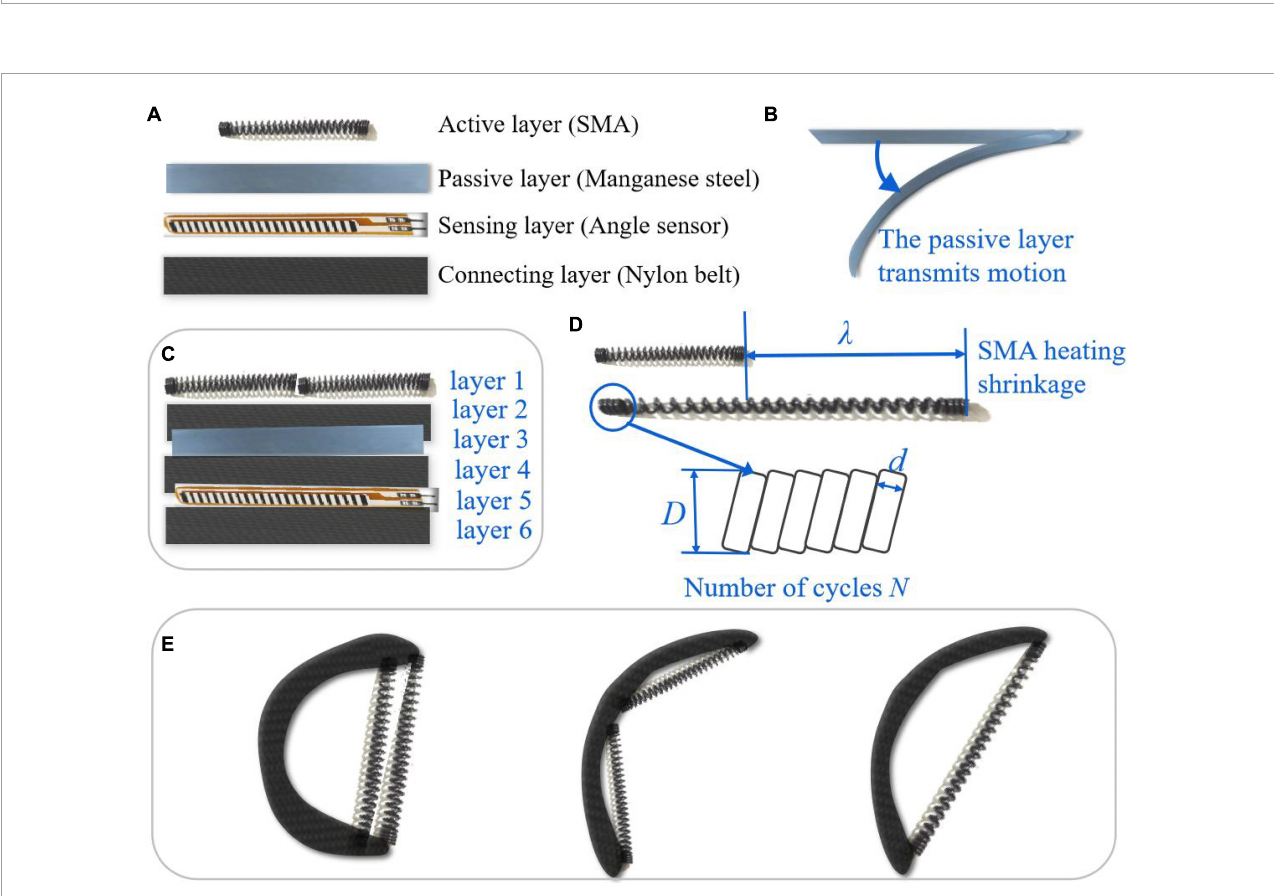
FIGURE4 SMA-based soft composite structure. (A,C) The design of SMA-based soft composite structure (SSCS); (B) the passive layer; (D) parameters of SMA springs; (E) different configurations of